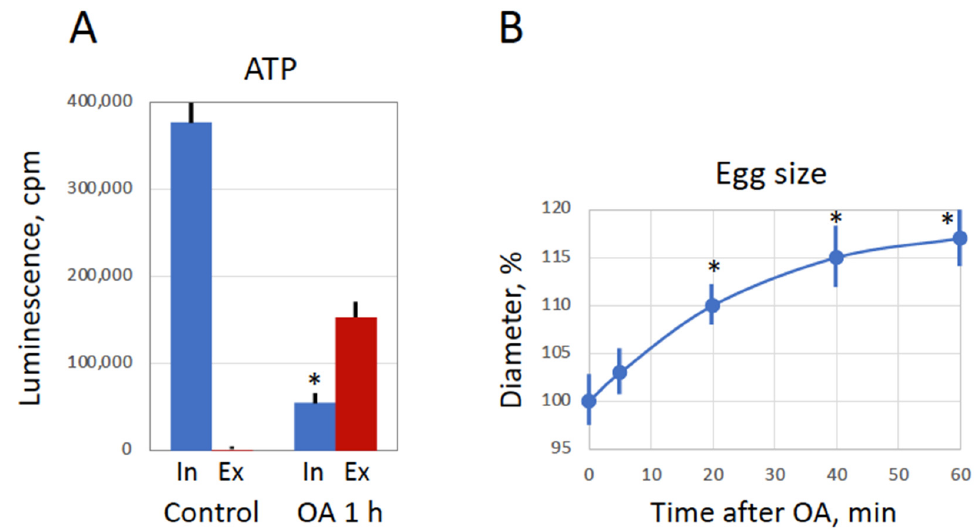
Figure 6. Breach of plasma membrane integrity in overactivated eggs. In vitro matured Xenopus eggs were treated with 10 mM hydrogen peroxide for one hour. Evaluations of intracellular (In) and ex ‐ tracellular (Ex) ATP in the cases of untreated (Control) and treated (OA 1 h) eggs are presented in panel ( A ). The progressive increase in the diameter of overactivated eggs is disclosed in panel ( B ). Panel ( A ) presents data of four to six ATP measurements in the same batch of eggs. More than ten eggs were analyzed in panel B at each time point. Asterisks denote statistical difference ( p < 0.05) from untreated control eggs.